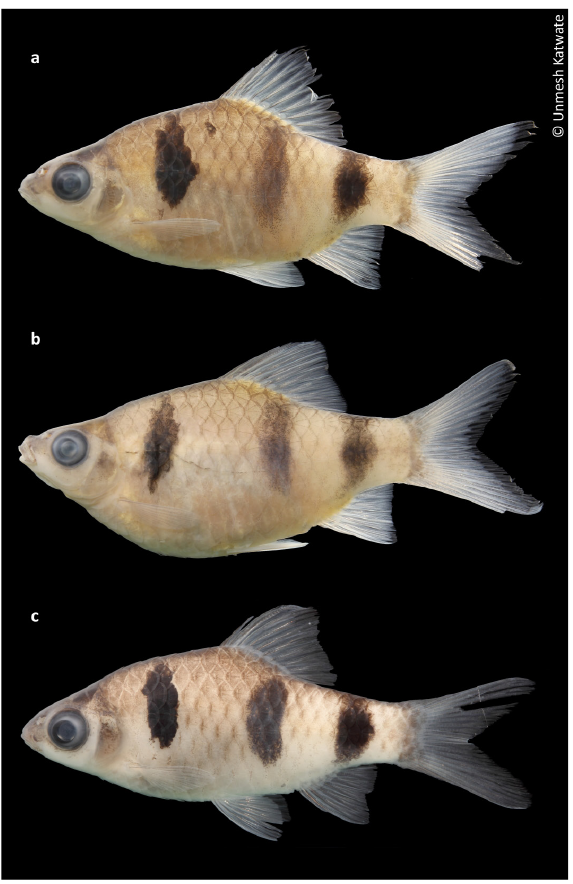
Image 3. Pethia setnai collected in the present study. a - Male from Sanguem, Goa, b - Female from Sanguem, Goa; c - unsexed individual from Madkhol, Maharashtra.